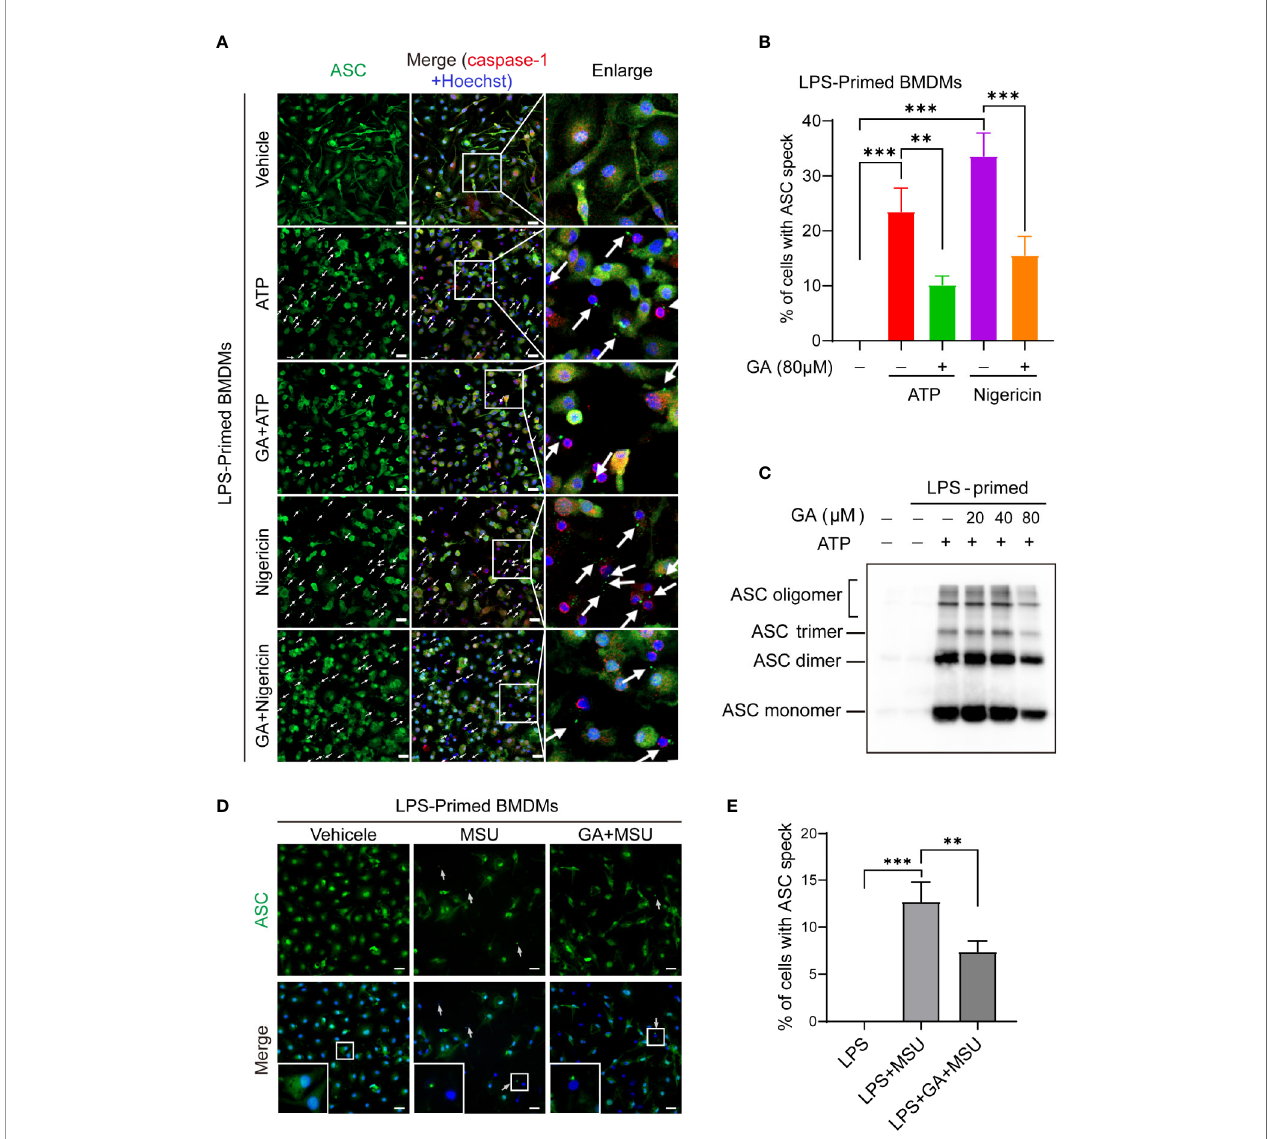
FIGURE 3 | Gallic acid blocks ASC oligomerization and speck formation. (A – E) LPS-primed bone marrow-derived macrophages (BMDMs) were incubated with gallic acid for 0.5 h before incubated with ATP or nigericin for 1 h, or monosodium urate (MSU) for 6 h. (C) ASC oligomerization in cross-linked cytosolic pellets from ATP-treated BMDMs was analyzed by immunoblotting. (A, D) Representative immuno fl uorescence images of ASC speck formation in LPS-primed BMDMs stimulated with ATP or nigericin or MSU in the presence or absence of gallic acid (80 µM). White arrows indicate ASC specks (green). Scale bars, 20 µm. Quanti fi cation of macrophages containing ASC speck formation in fi ve random images is shown in (B, E) . GA, gallic acid. ** P < 0.01, *** P <